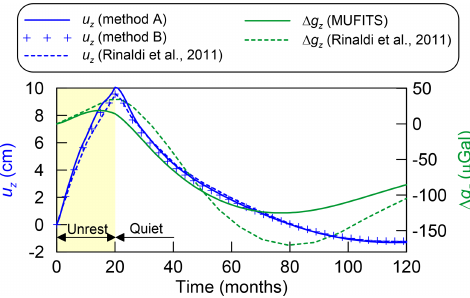
Table 1. Parameters of the benchmark study. Porosity 0.2 Permeability 10mD Thermal conductivity of the solid phase 2.8W(mK) − 1 P atm 1bar 20 ◦ C 50 ◦ Ckm − 1 Relative permeability Corey’s curves with end-point saturations of 0.3 and 0.95 Capillary pressure 0 Injection fluid enthalpy Corresponds to T = 350 ◦ C at P = 180bar CO 2 / H 2 O molar ratio of magmatic fluid Quiet: 0.17, Unrest: 0.4 Injection rate